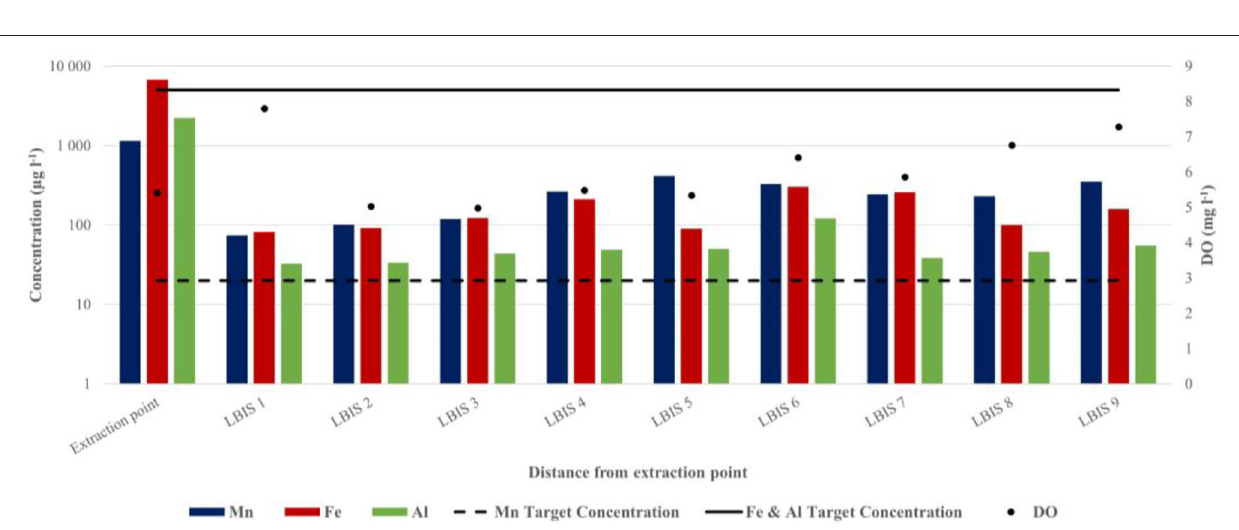
FIGURE 6 | Total Mn, Fe, Al, and DO concentrations in water sampled at the extraction point and downstream on routes 1, 2, and 3 (February 2017). The respective downstream distances are: LBIS 1–4.5km, LBIS 2–6km, LBIS 3–23km, LBIS 4–26.3km, LBIS 5–25km, LBIS 6–28.4km, LBIS 7–17.6km, LBIS 8–27.3km, LBIS 9–31.7km. The dotted and solid lines indicate SA target water quality range in irrigation water for Mn, Fe, and Al,